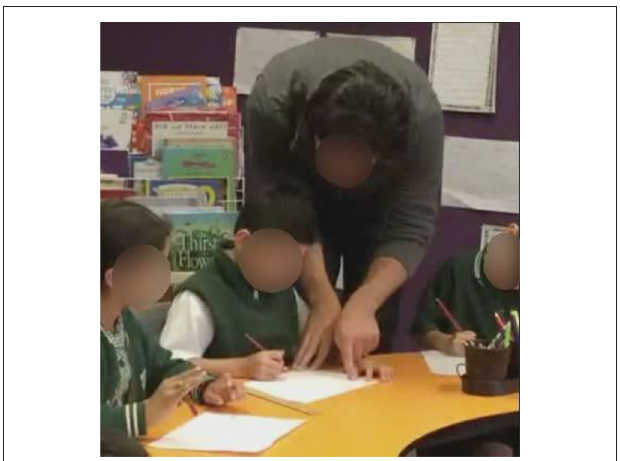
FIGURE 5 | Colin focuses Noel’s attention on representing the sun and its movement in the drawing.